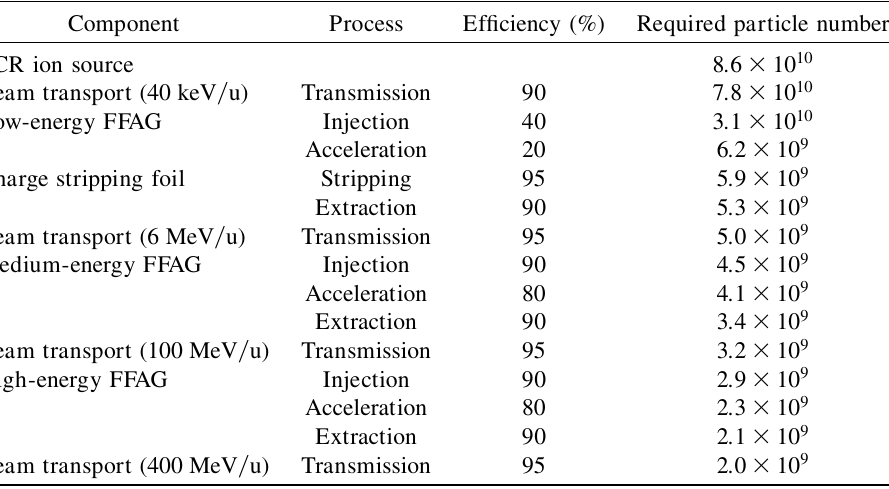
TABLE IV. Estimated beam transmission rate.